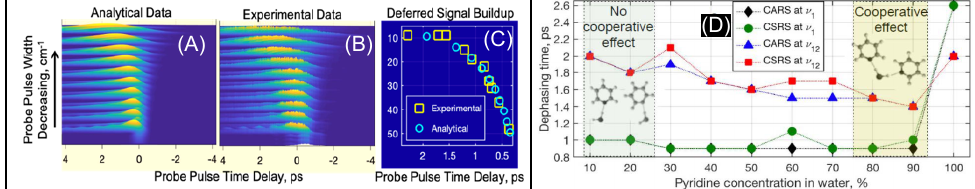
Figure 3. ( A – C ) Data for the new effect: A deferred macroscopic quantum coherence buildup in a molecular system. ( A ) Analytical results based on the Faddeeva function for a pair of vibrational ring modes of pyridine molecules. ( B ) Experimental results as probe pulse width varies but pump pulses remain unchanged. ( C ) A comparison between analytical and experimental data for the triangular ring vibrational mode of pyridine molecules. ( D ) A cooperative effect observed in pyridine–water complexes. At higher concentration of pyridine molecules, more water molecules tend to bond with pairs of pyridine molecules, and effectively escalate dephasing rate of the mixture.